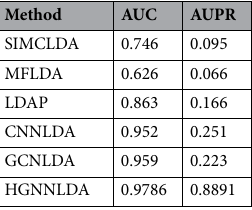
Table 1. The mean AUCs and AUPRs of different